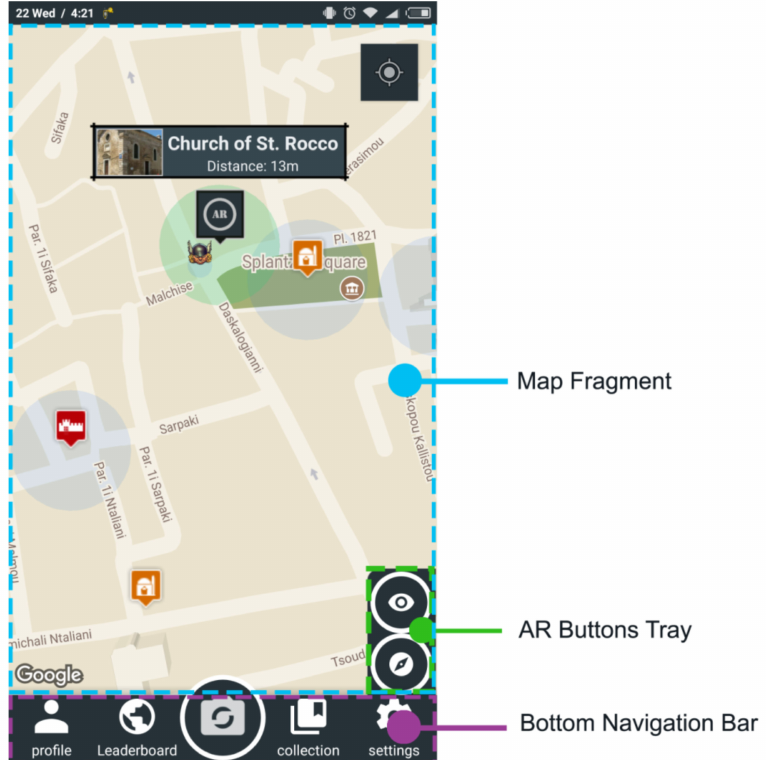
Figure 16. Map activity user